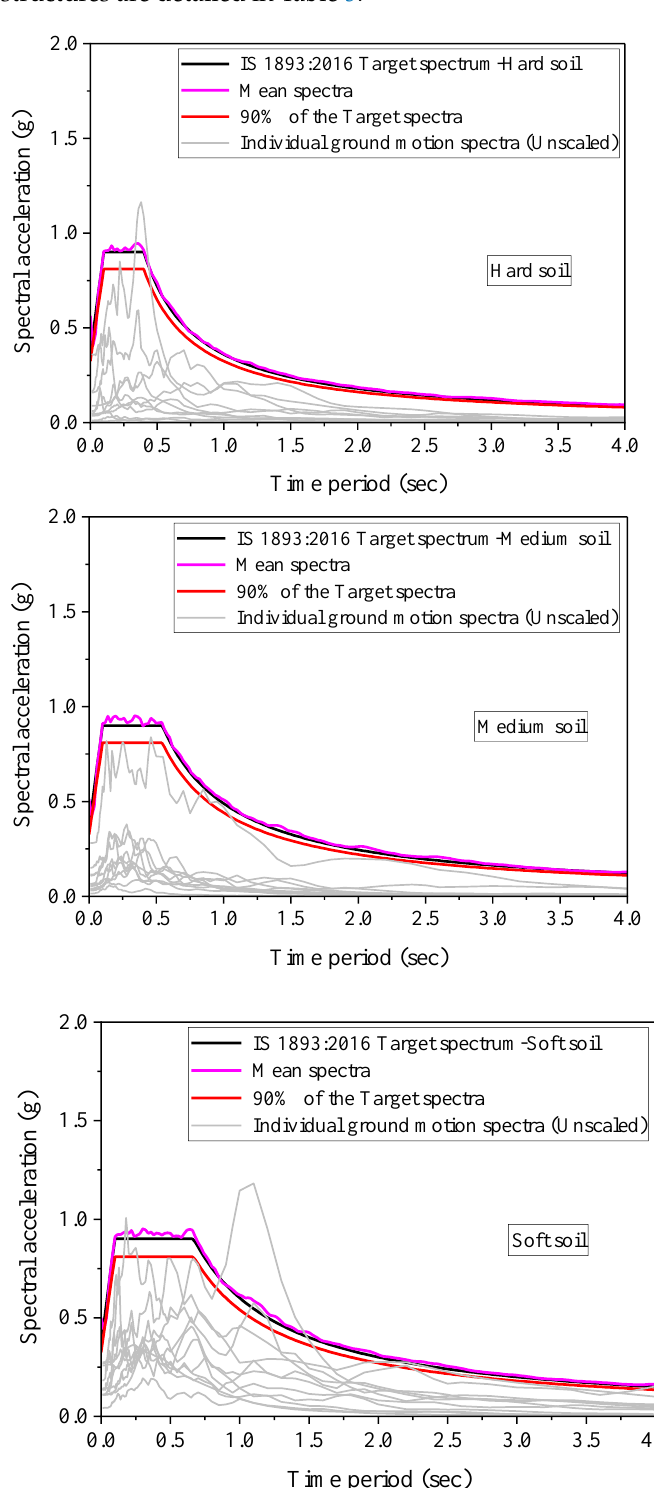
Figure 3. Target and mean acceleration spectra for various soil types.